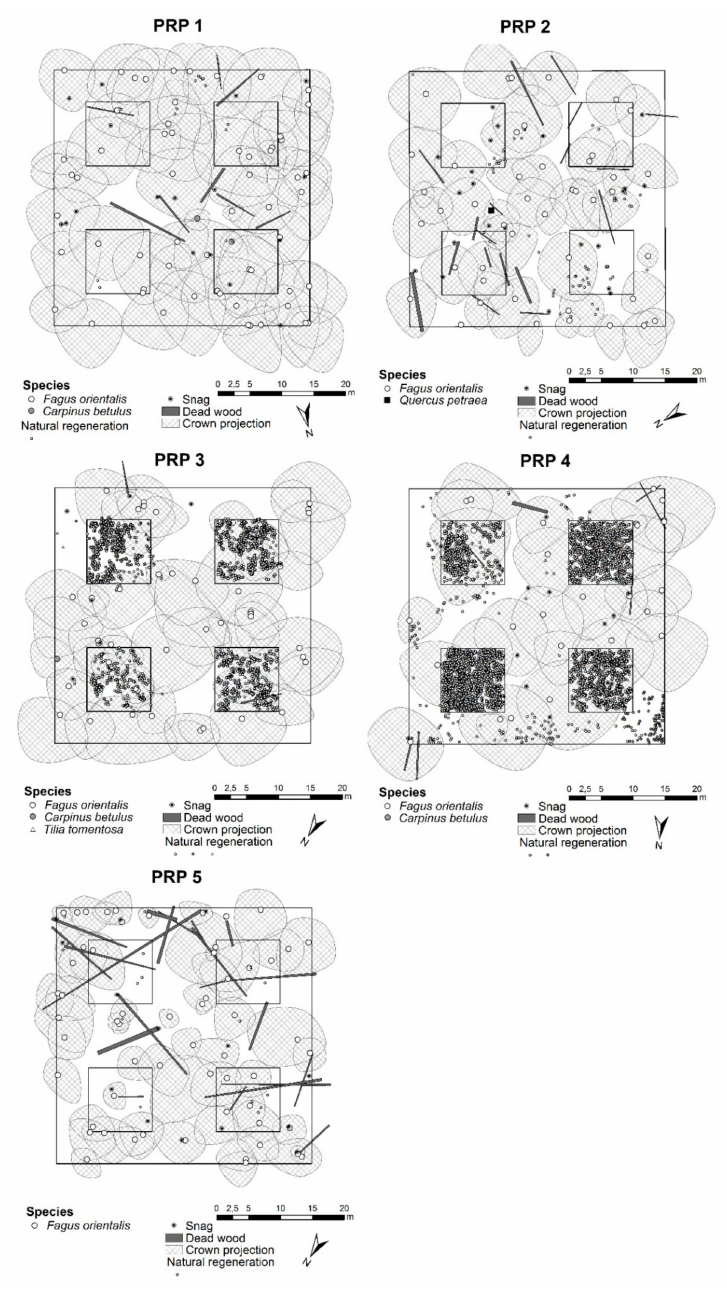
Figure 2. Horizontal structure of the tree layer and natural regeneration on permanent research plots (PRP)